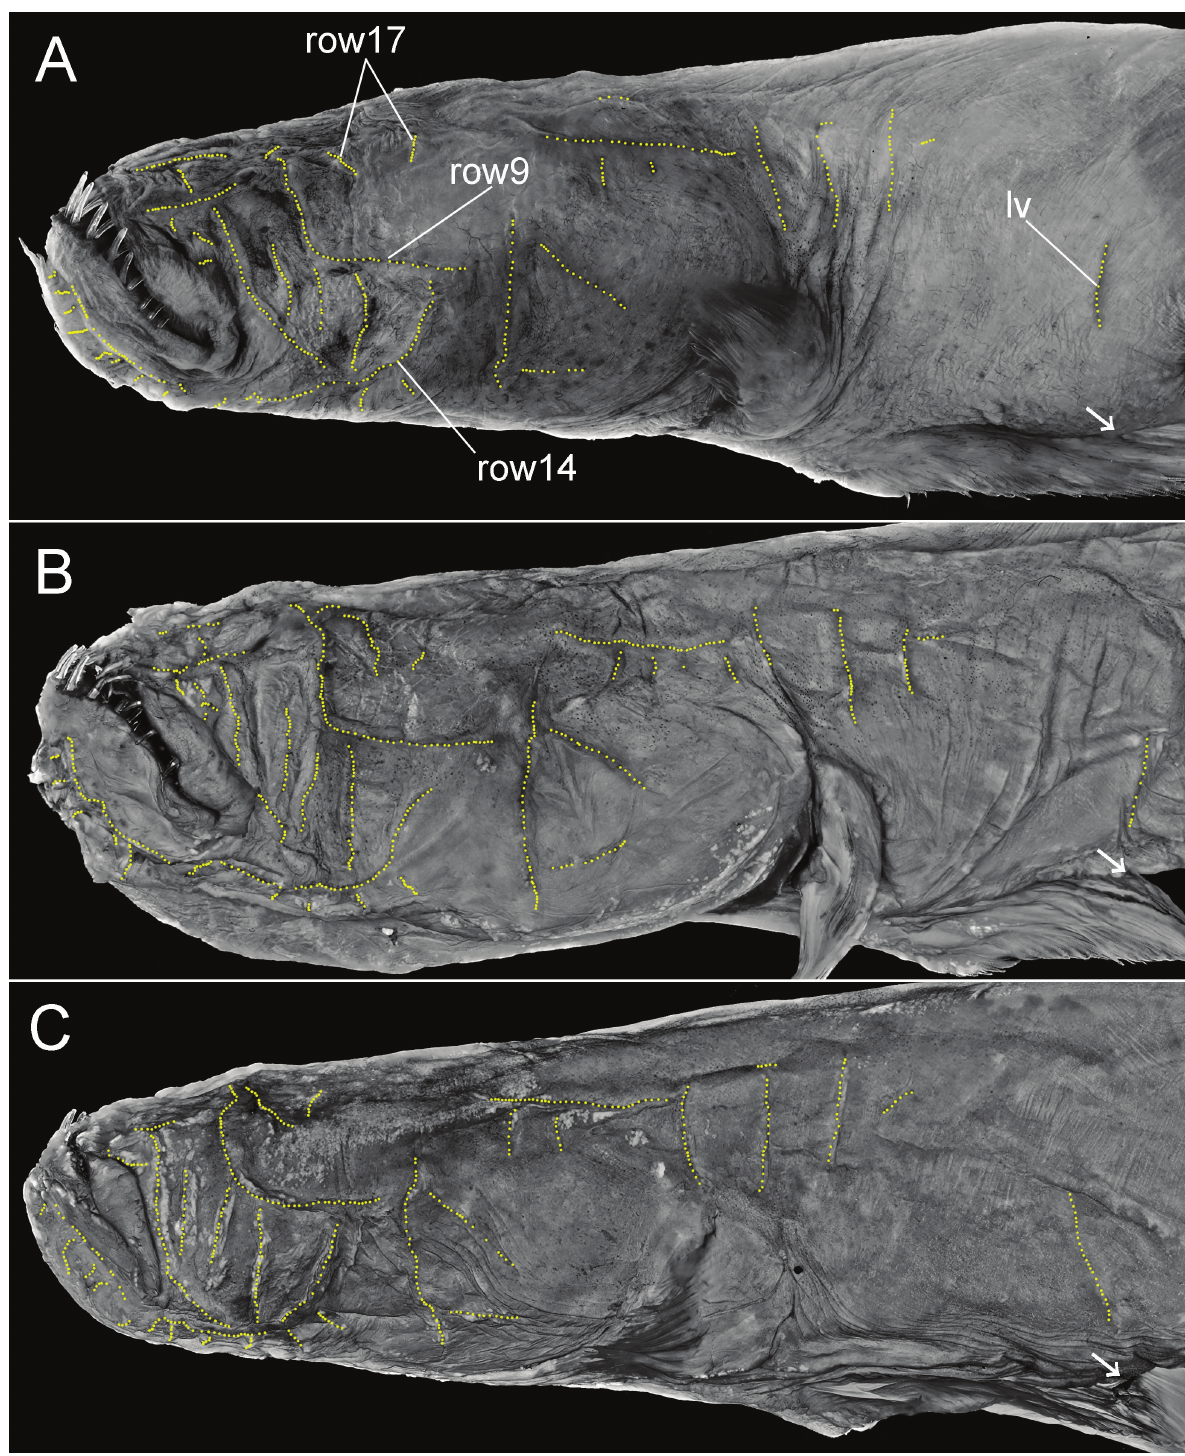
Figure 2. Head view of Taenioides snyderi from Taiwan, showing sensory papillae rows on the dermal fold (individual papillae indicated by yellow spots). White arrows indicate posterior end of pelvic-fin base. A : NMMB-P5491, 150.7 mm SL, Chiayi; B : one of NMMB-P32256, 156.8 mm SL, Zengwen River; C : one of NMMB-P32256, 160.9 mm SL, Zengwen